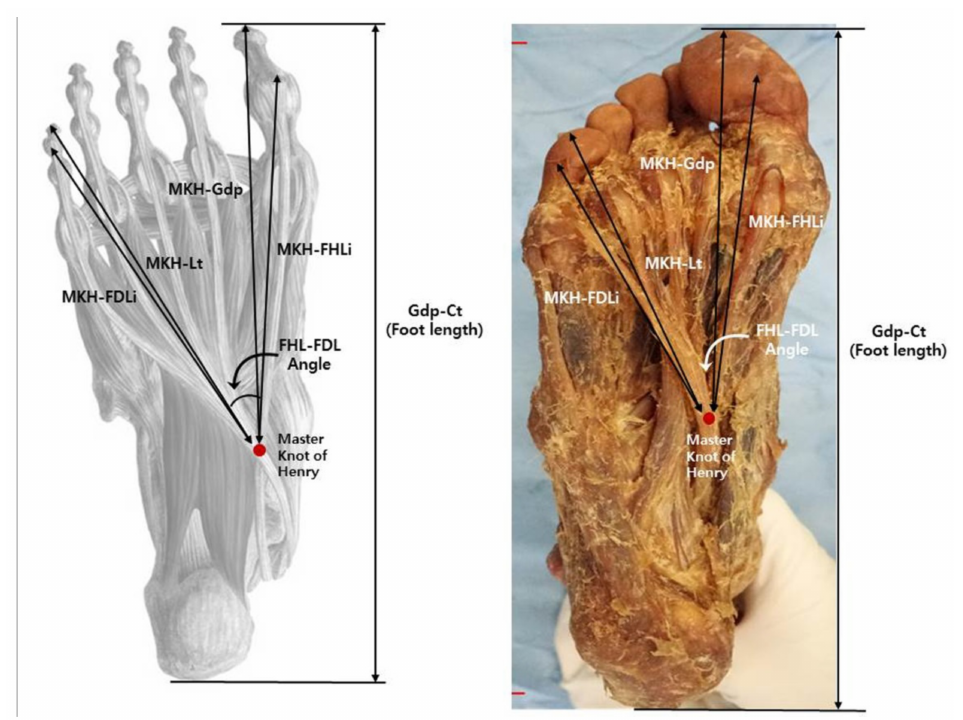
Figure 1. Schematic diagram of the foot showing foot length and MKH-landmark length measure- ments. Gdp-Ct, great toe distal phalanx-calcaneus tuberosity; MKH-Gdp, Master Knot of Henry-great toe distal phalanx; MKH-FHLi, Master Knot of Henry-FHL insertion; MKH-Lt, Master Knot of Henry-little toe distal phalanx; MKH-FDLi, Master Knot of Henry-FDL little toe insertion; FHL, flexor hallucis longus; FDL, flexor digitorum longus.